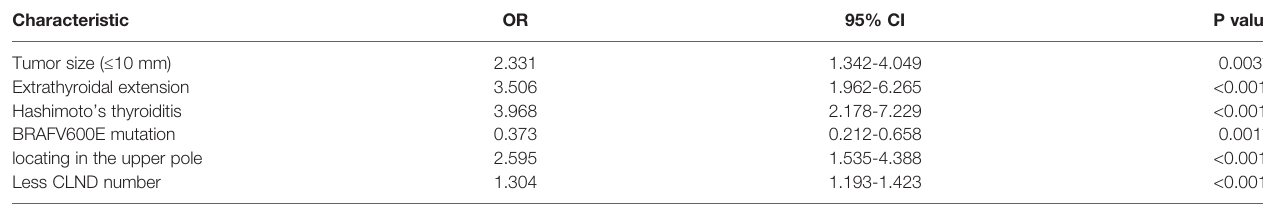
TABLE 2 | Multivariate analysis between the clinicopathologic factors and skip metastasis.